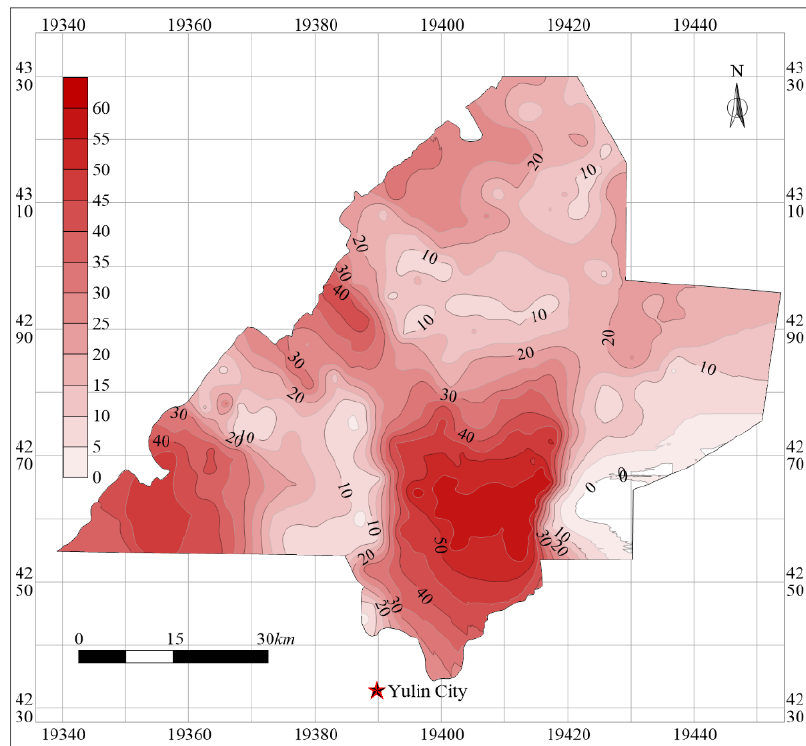
Figure 11. Caved zone height contour (Xi’an geodetic coordinate system 1980; in km).